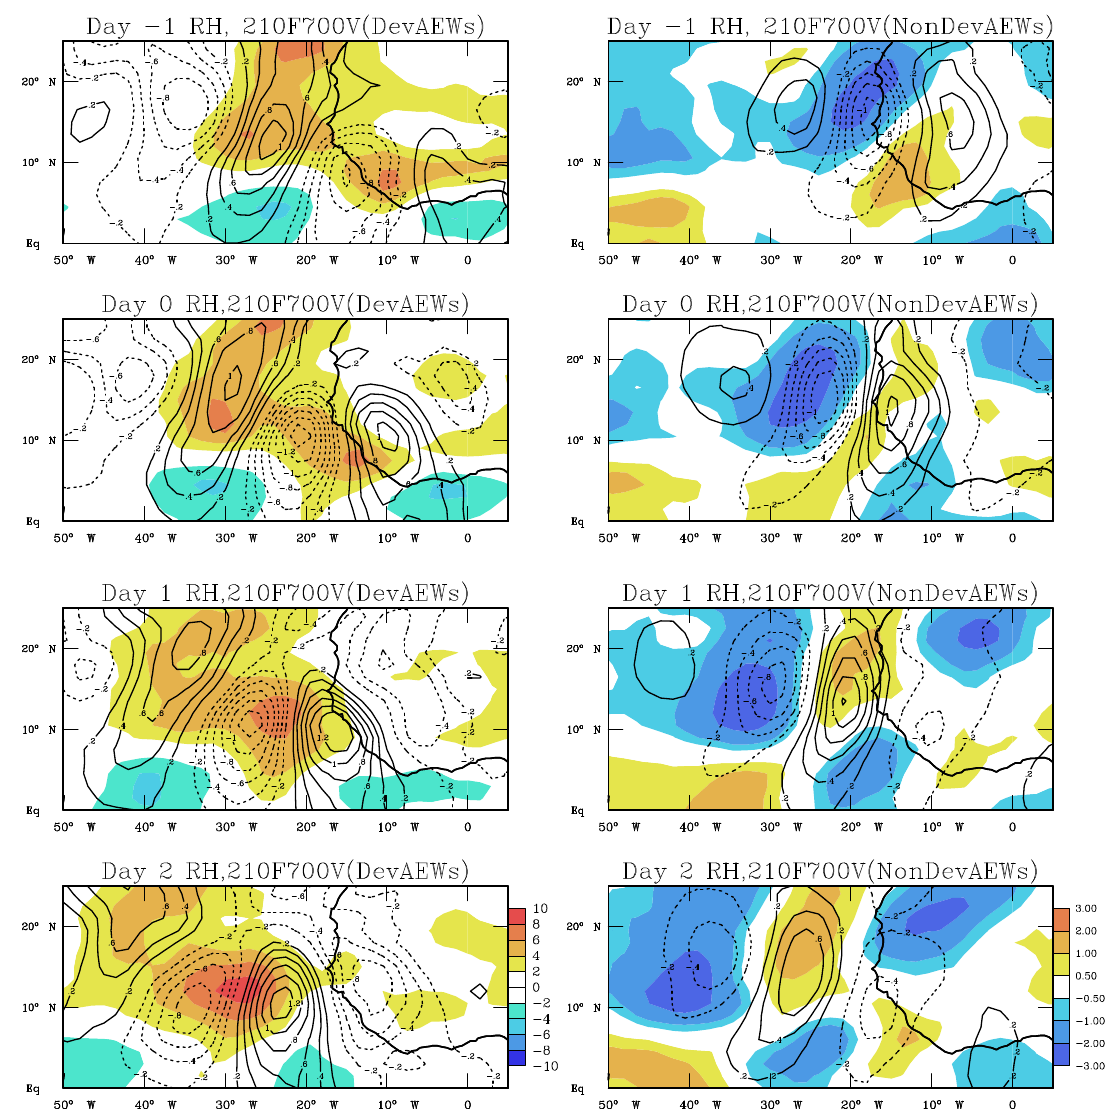
Figure 5. Composites of 700 hPa relative humidity anomaly (shaded, July–October 1984–2009 subtracted) and 2–10 day filtered meridional wind (contoured every 0.2 m/s, dashed for northerlies and solid lines for westerlies). Composites based on developing AEWs are shown on the ( left panel). Composites based on non-developing AEWs are presented on the ( right panel). Note the scale difference in the color bar between the left and right panels.